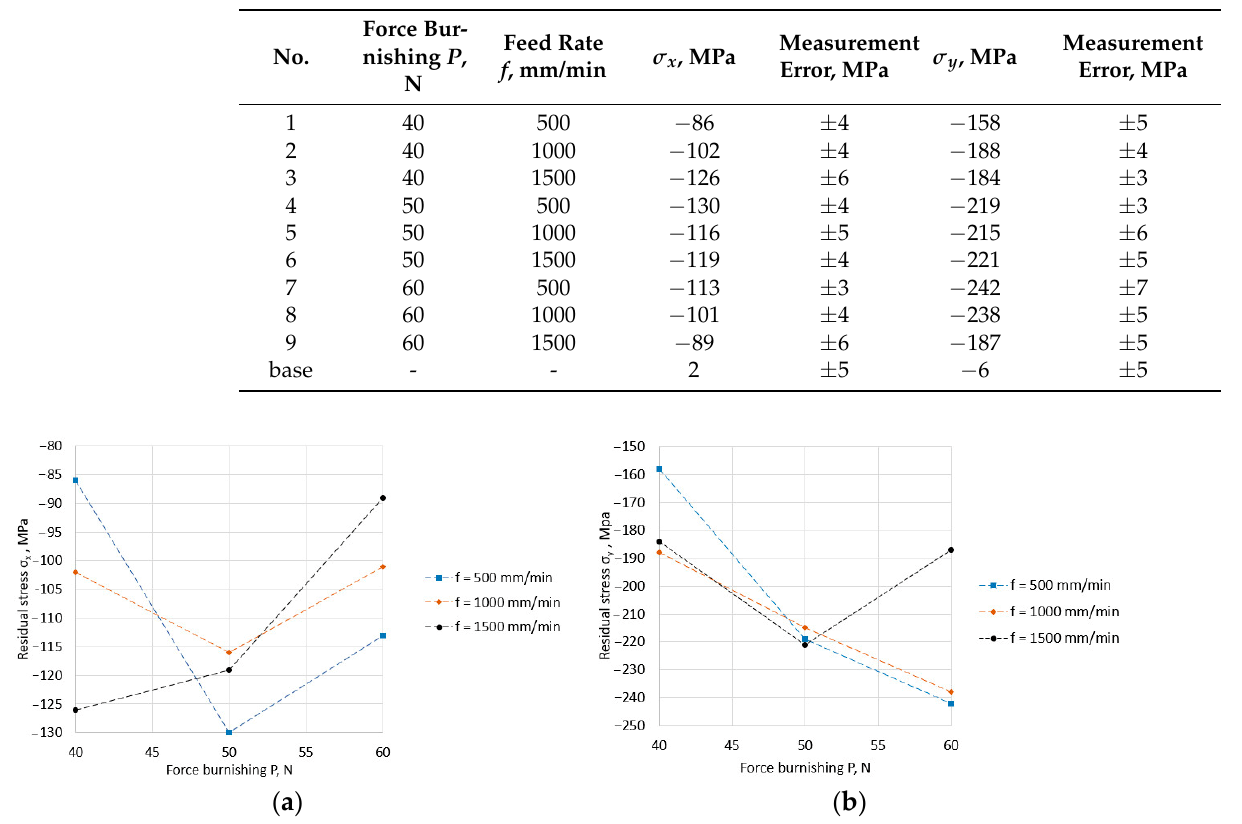
Figure 4. Influence of feed rate and force burnishing on residual stress value ( a ) in the transverse direction σ x , ( b ) in the longitudinal direction σ y